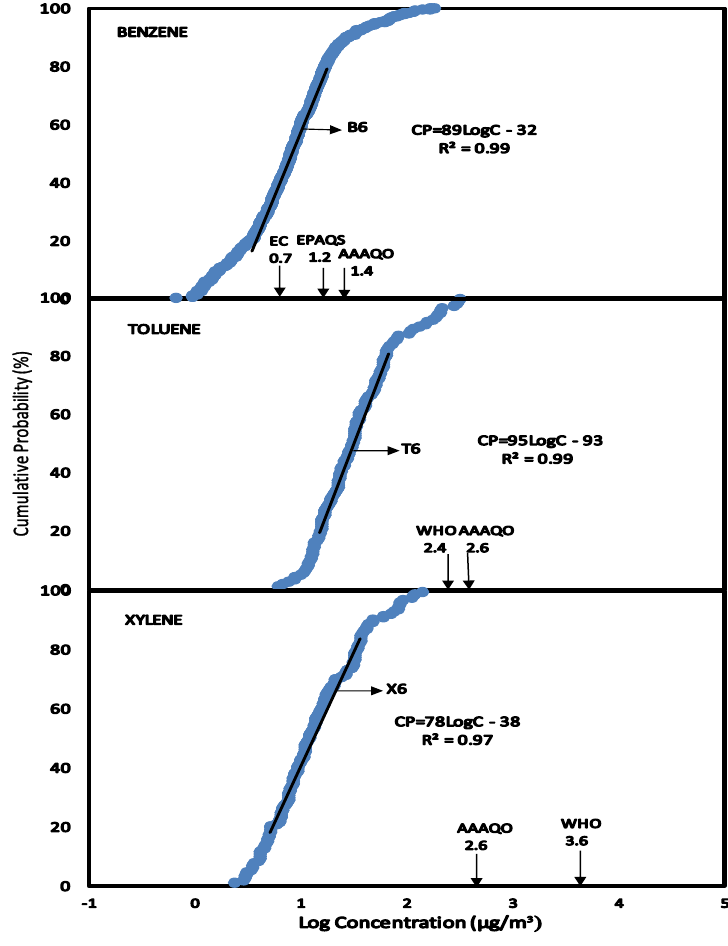
Figure 6. Scenario 6, CPD plots for exposure to people outside the service stations to concentrations of benzene, toluene and xylene from the service stations as measured by static air sampling